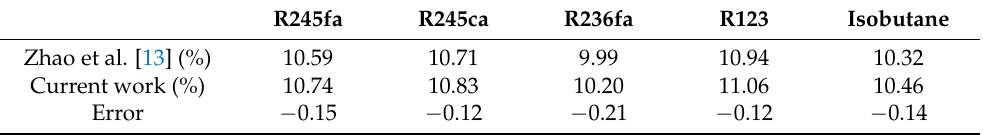
Table 2. Comparison of the thermal efficiency of cycles from Zhao et al. [13] and the current model.